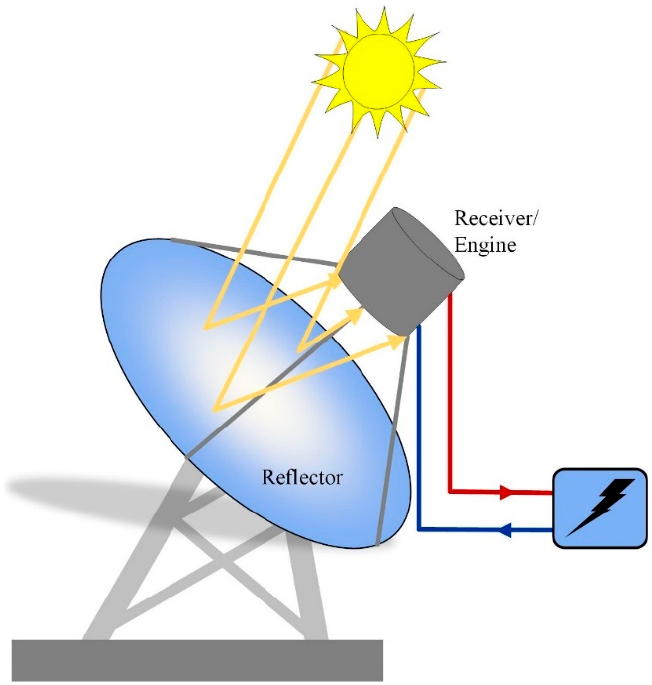
Figure 6. A schematic diagram of the parabolic dish (PD) system.